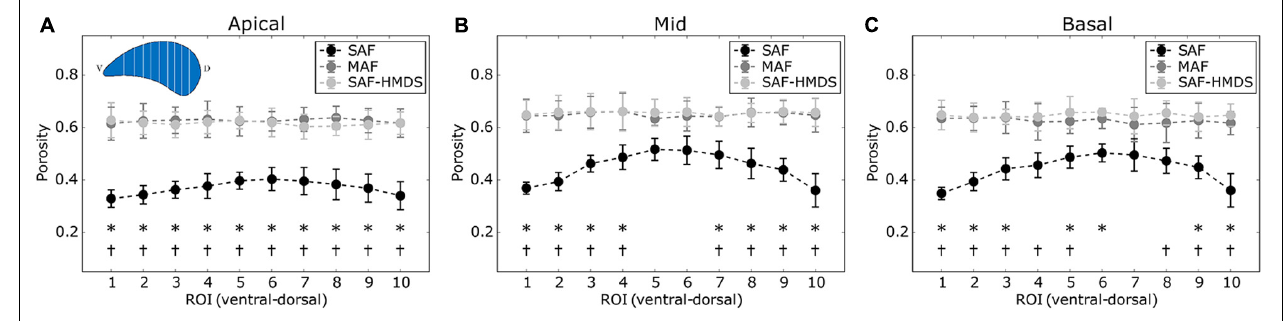
FIGURE 4 | Regional distribution of porosity in the ventral-dorsal direction for three regions of the lung: (A) apical zone, (B) mid zone, and (C) basal zone. Significant differences ( p -value ≤ 0.05) between the SAF and MAF, SAF and SAF-HMDS, MAF, and SAF-HMDS groups are indicated by ∗ , † , respectively. Each group ROI considered n = 9